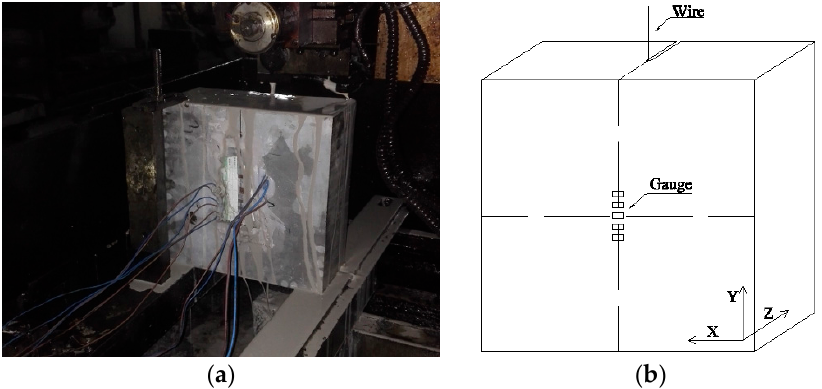
Figure 3. ( a ) Photo and ( b ) schematic view of the Crack Compliance Method (CCM) measurement setup.